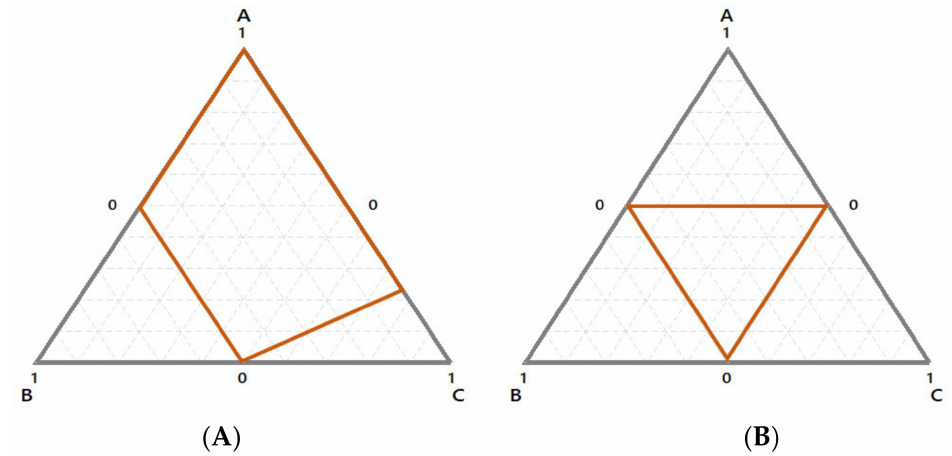
Figure 2. Reduced domains with irregular ( A ) or regular shape ( B